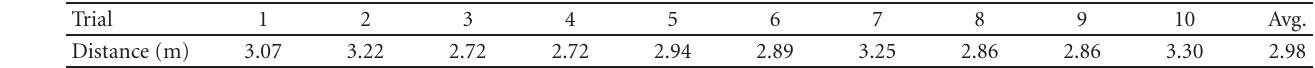
Table 3: Kicking distance in Air.